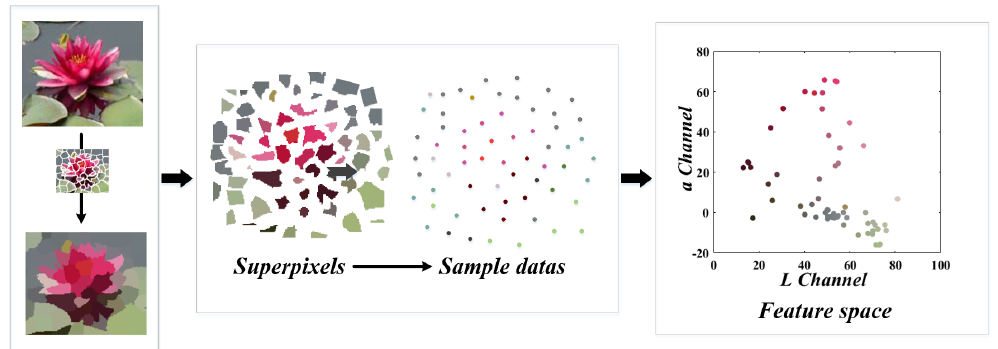
Figure 3. The flowchart of Sections 2.1 and 2.2. The small image is an interesting region selected from the original image, and this interesting region is divided into 62 superpixels. We consider each superpixel as a sample point and represent them in feature